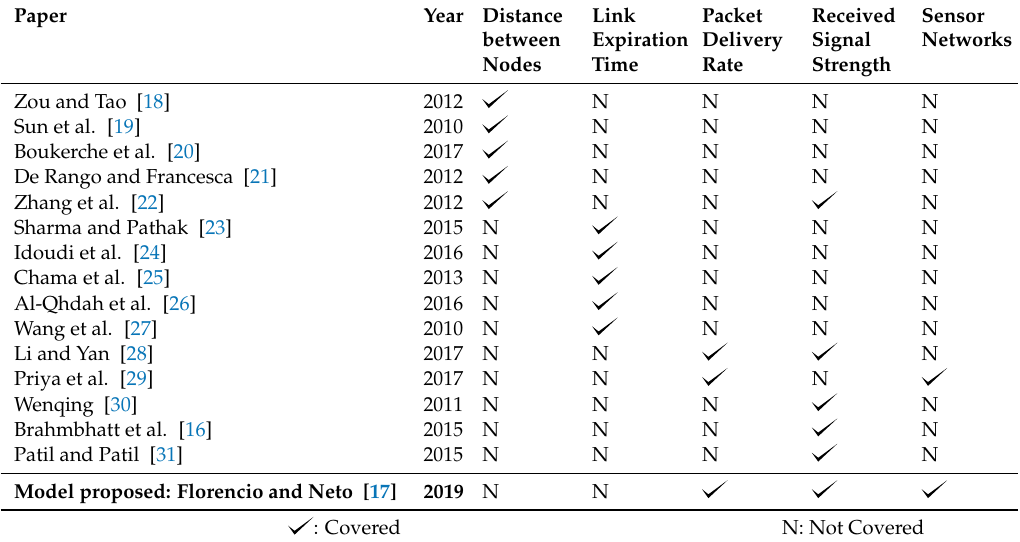
Table 1. Papers that define link stability and its